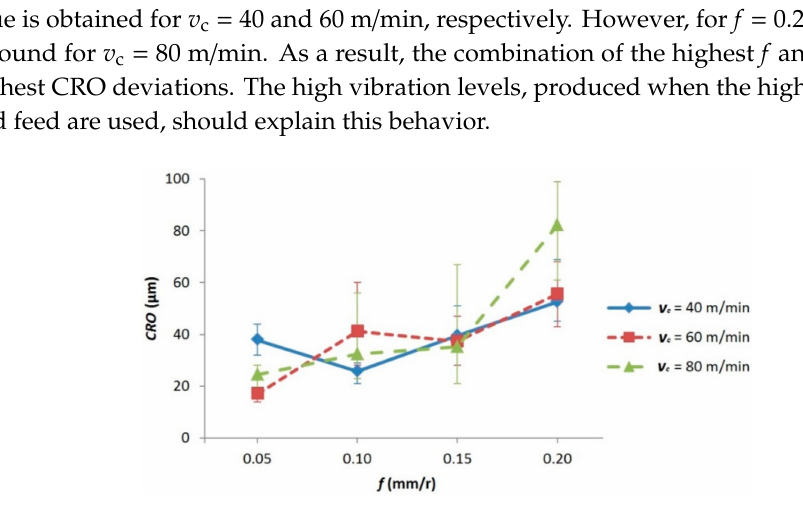
Figure 11. Circular run-out mean values as a function of cutting speed ( v c ) and feed ( f